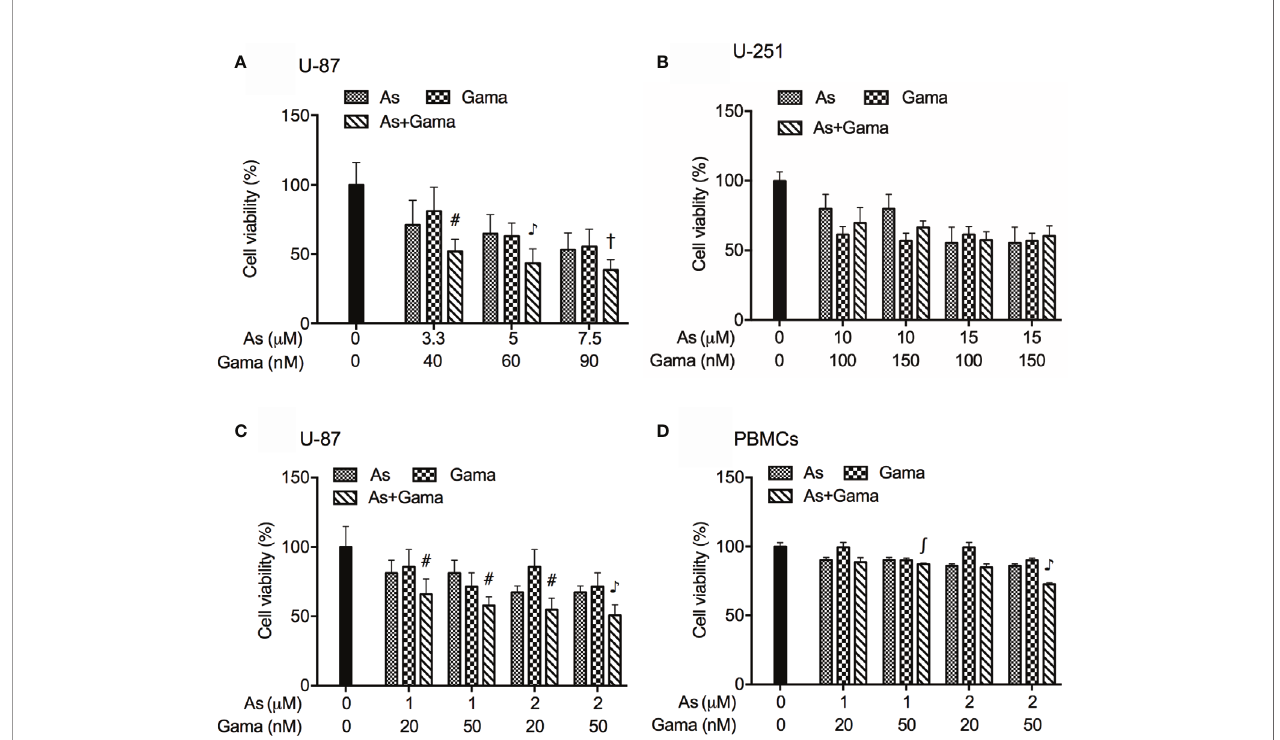
FIGURE 3 | Synergistic cytotoxic effect of As III and gamabufotalin in U-87 but not in U-251 cells. (A) U-87 cells were treated with relatively high concentrations of As III (3.3, 5, and 7.5 µM) and gamabufotalin (40, 60, and 90 nM), alone or in combination. (B) U-251 cells were treated with relatively high concentrations of As III (10 and 15 µM) and gamabufotalin (100 and 150 nM), alone or in combination. U-87 (C) and PBMCs (D) were treated with relatively low concentrations of As III (1 and 2 µM) and gamabufotalin (20 and 50 nM), alone or in combination. Following the aforementioned treatment for 48 h, cell viability was determined by XTT assay. Relative cell viability was calculated as the ratio of the absorbance at 450 nm of each treatment group against those of the corresponding untreated control group. Data are shown as the means ± SD (n ≥ 3). ∫ p < 0.05; # p < 0.01; † p < 0.001; ♪ p < 0.0001 vs. each alone. As, As III ; Gama, gamabufotalin.